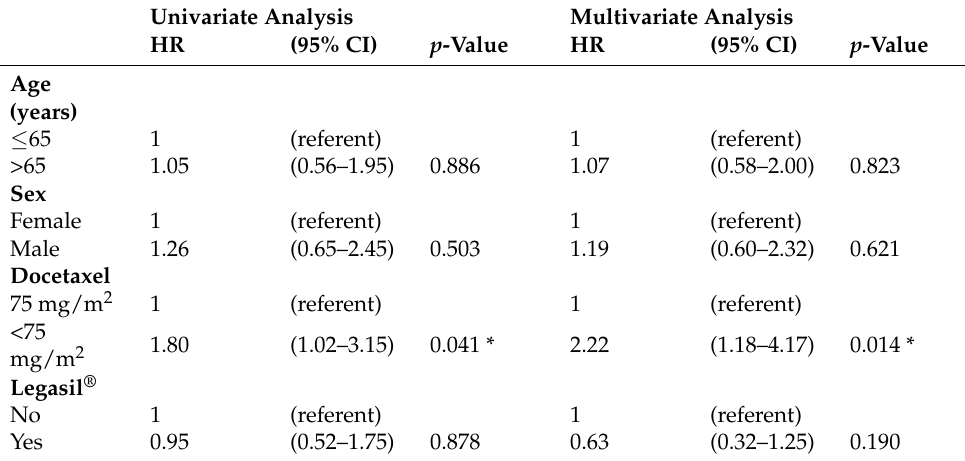
Table 4. Univariate and multivariate Cox proportional analysis for